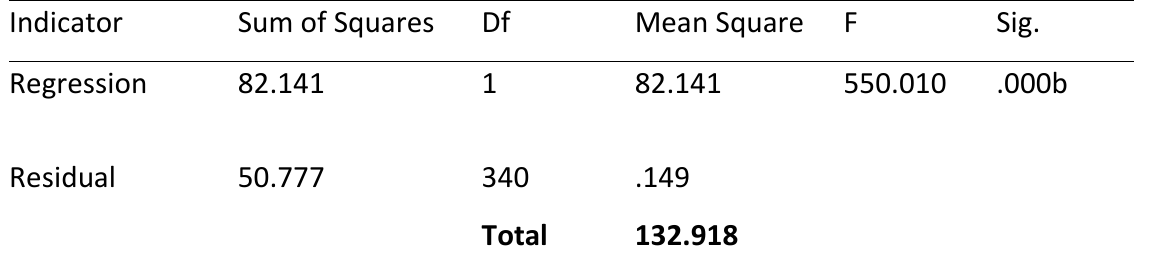
Table 9. Analysis of variance Indicator Sum of